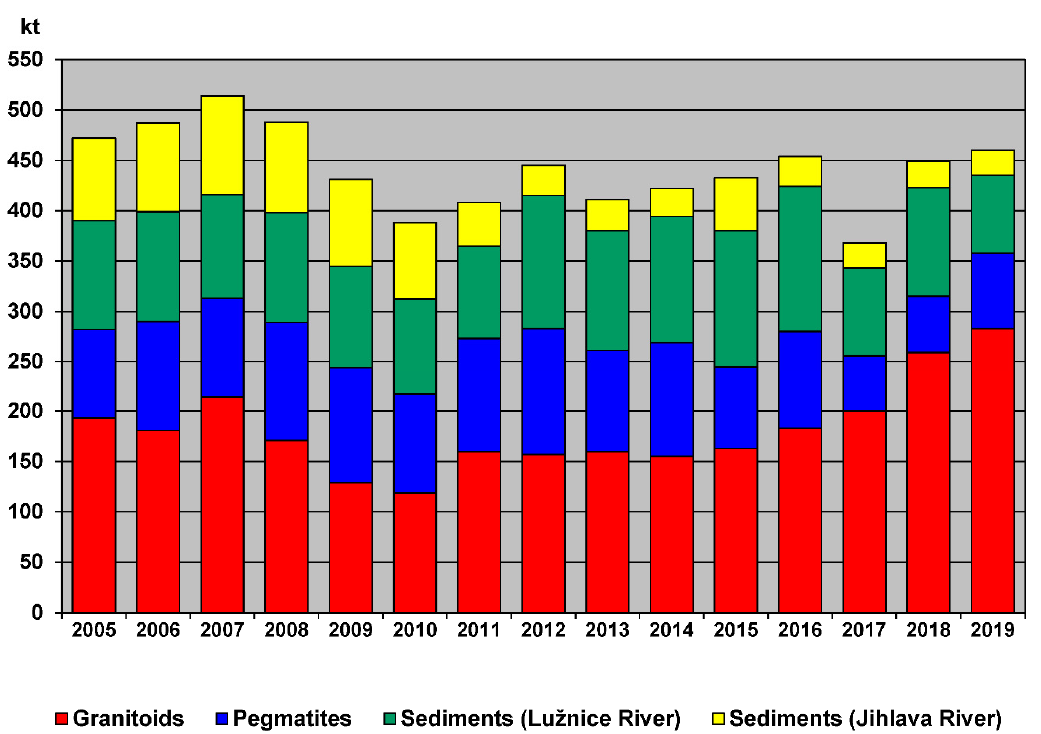
Figure 4. Mine production from different geological types of Czech feldspar deposits (modified after [36,38–40]).